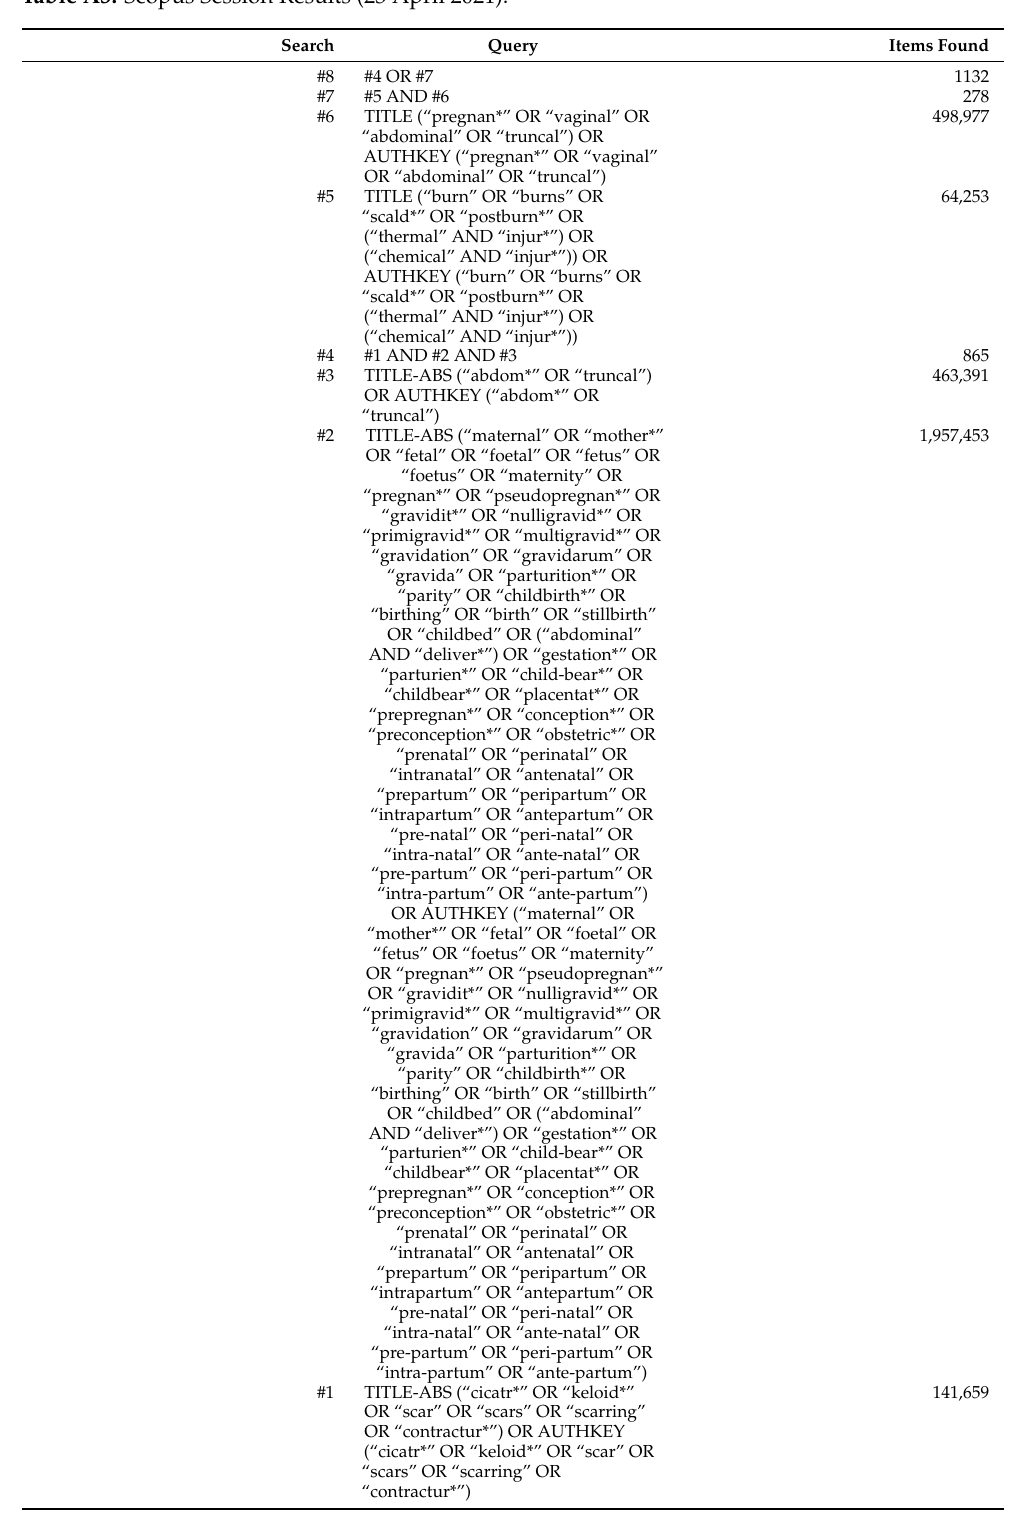
Table A3. Scopus Session Results (23 April